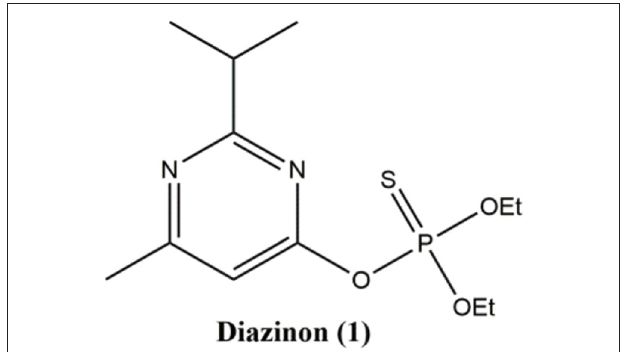
FIGURE 1 | Pesticide under